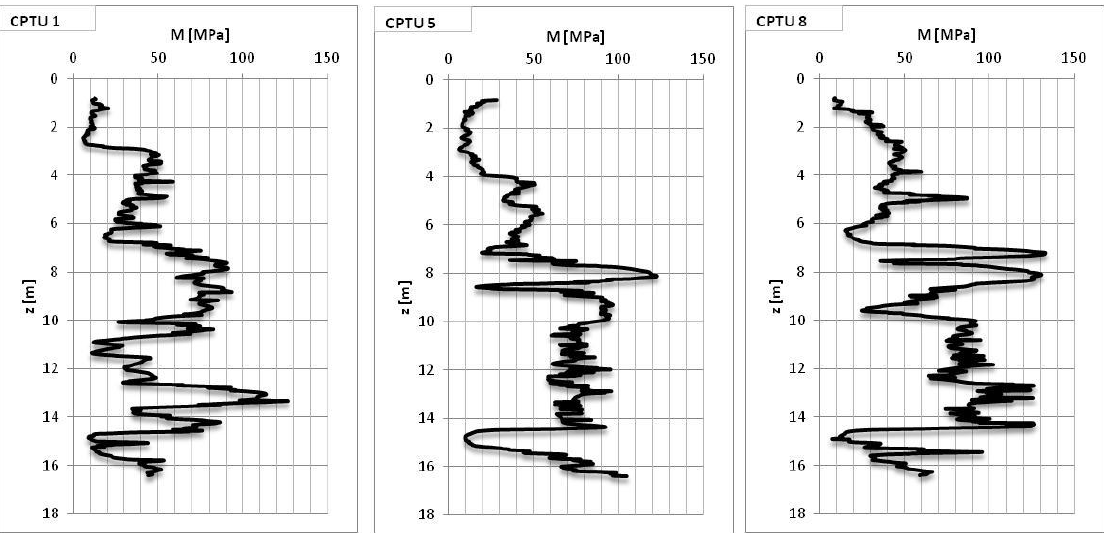
Figure 6. Changes in constrained moduli M with depth along three arbitrarily selected CPTU profiles.